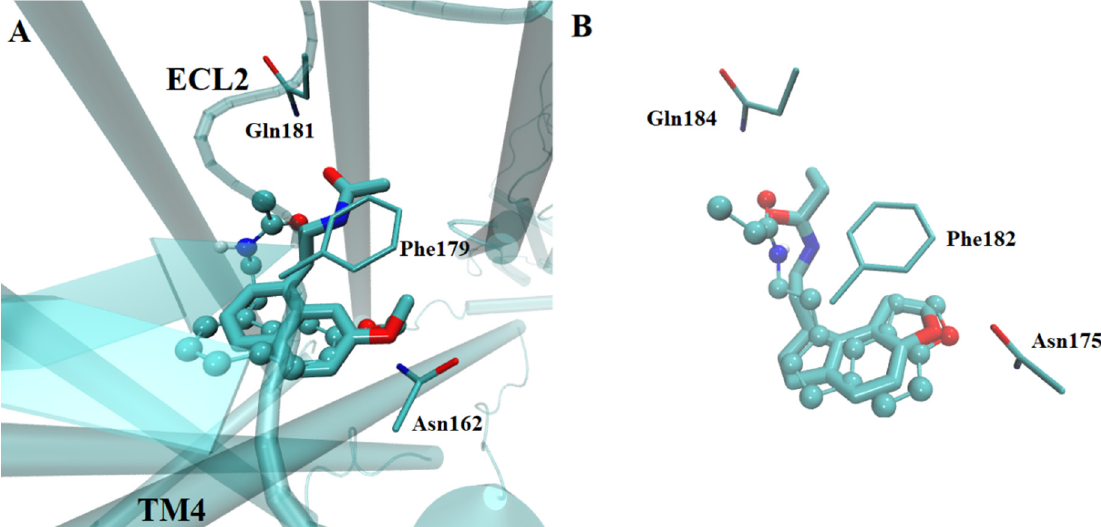
Figure 4. Overlay of docked ligand structures (in stick and balls representation) on human MT1 (( A ), with agomelatine) and MT2 (( B ), with ramelteon) melatonin receptors as they are found in the crystal complexes. The sidechain of some residues considered key in the binding pocket are depicted as reference. High similarity in the binding sites of both receptors is notable. Oxygen atoms are in red color, nitrogen atoms are in blue color.